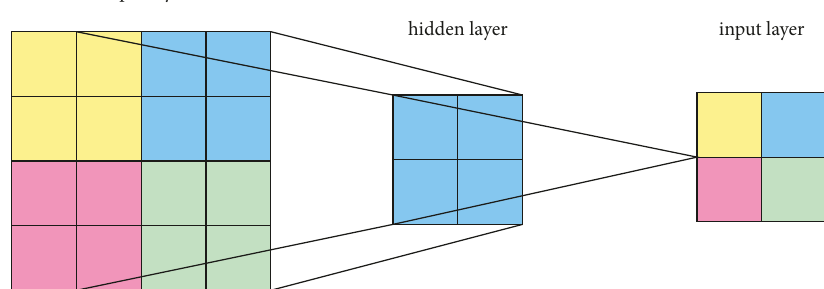
Figure 3: Schematic diagram of the output of the pooling layer.